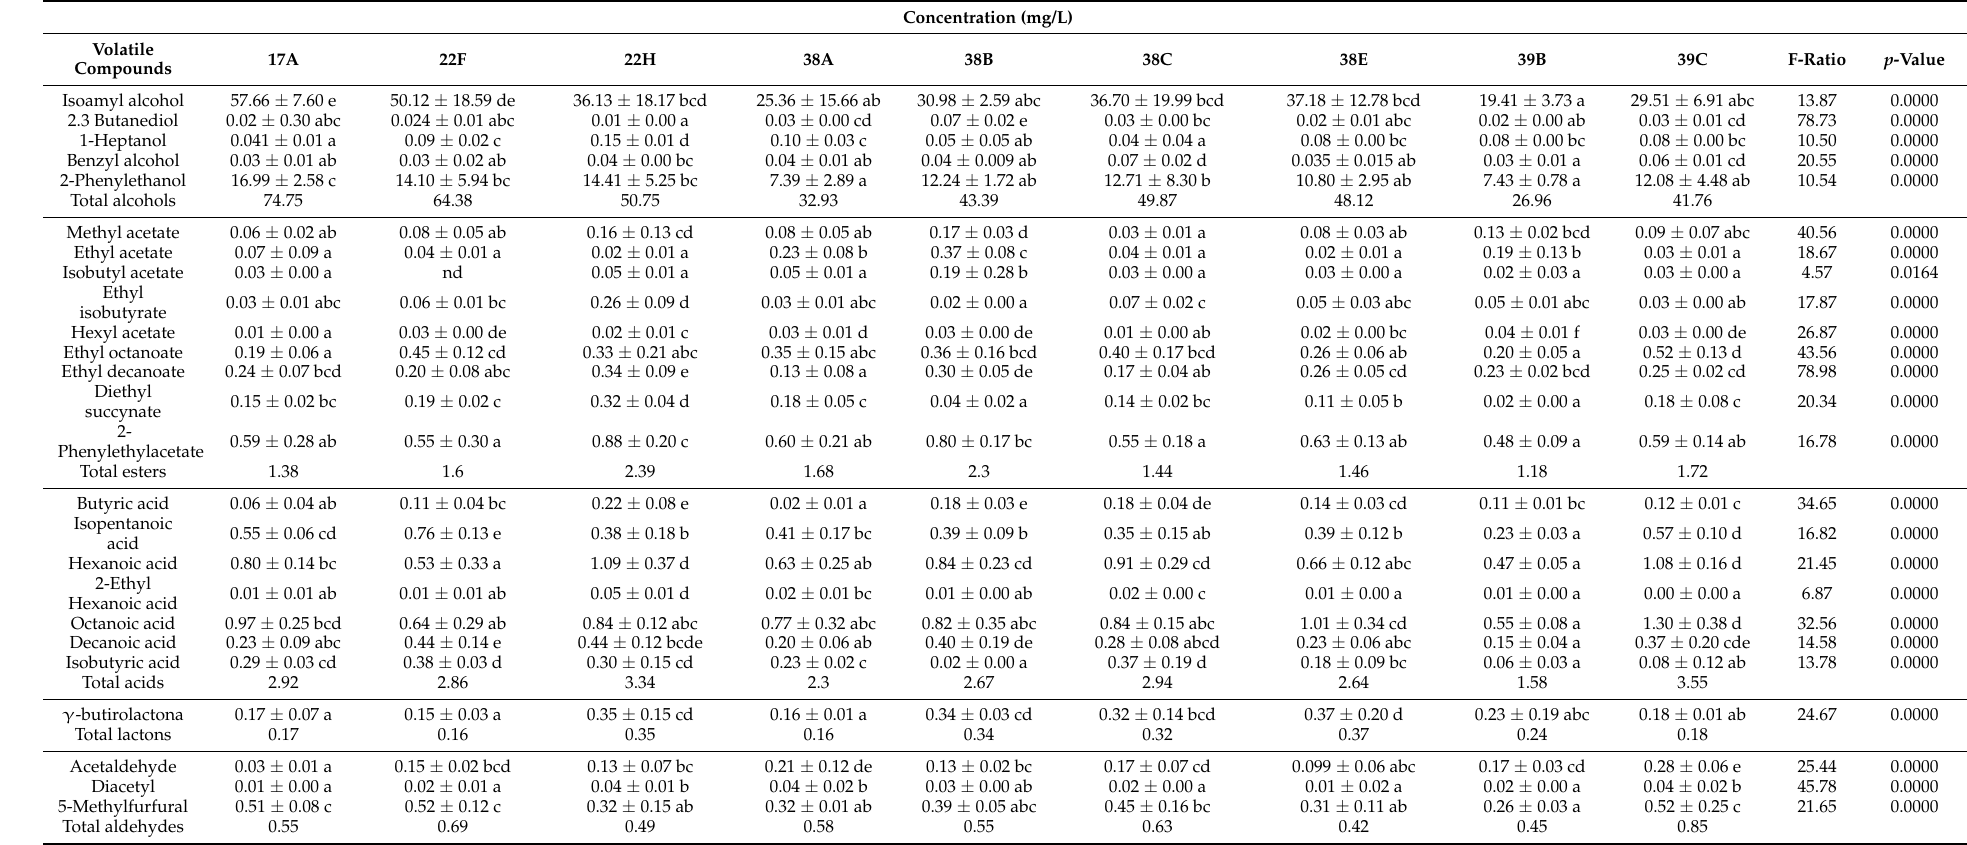
Table 4. Effect of fermentation with selected yeast strains on the aromatic compounds of Garnacha